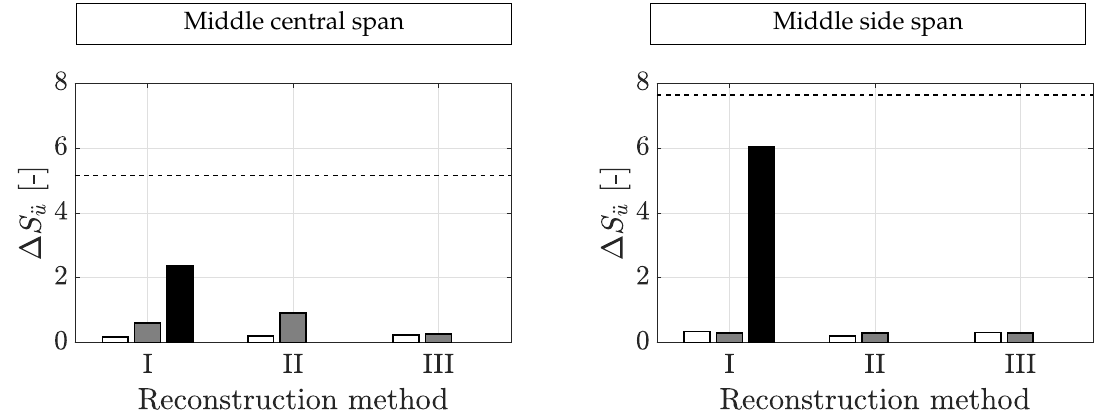
Figure 18. Relative error in PSD of the reconstructed to the reference structural response at the middle of the central span and middle of the side span. The internally-driven contact forces are reconstructed using either the internally-driven L5 accelerations (white) or the total L5 accelerations (gray) using three different reconstruction methods. The total contact forces are reconstructed using the total L5 accelerations (black, only reconstruction method I). The dashed horizontal line is the relative difference in PSD of the vertical structural acceleration with and without mechanical HSI.